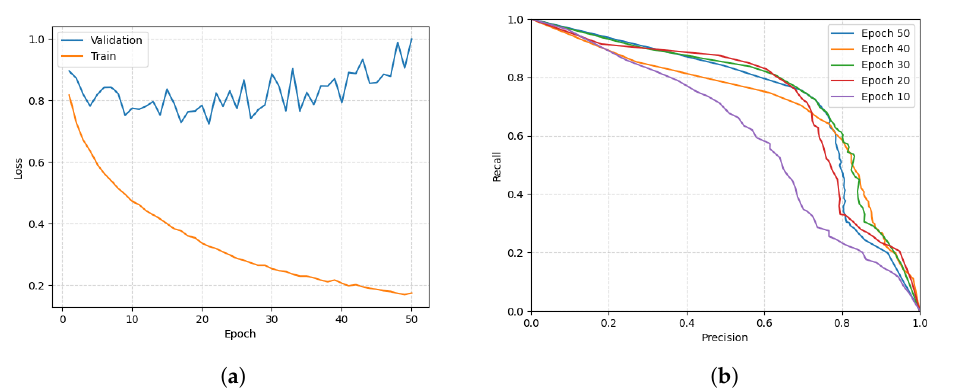
Figure 4. In ( a ), a typical normalized training loss is displayed and in ( b ) a PR curve computed on the validation split at different training epochs is